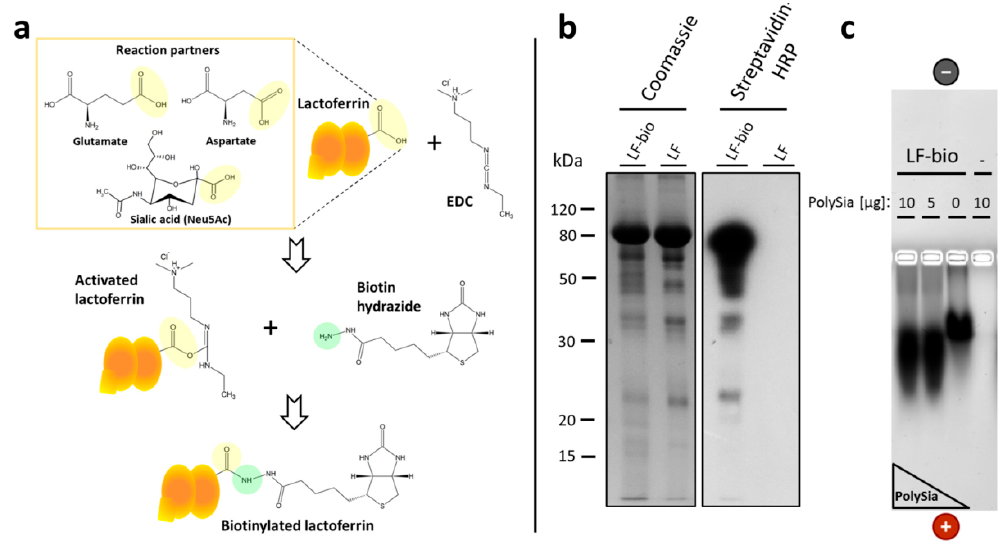
Figure 5. Biotinylation of bovine lactoferrin. ( a ) Bovine lactoferrin was biotinylated using 1-ethyl-3-(3-dimethylaminopropyl)carbodiimid (EDC) and biotin-hydrazide under acidic conditions.